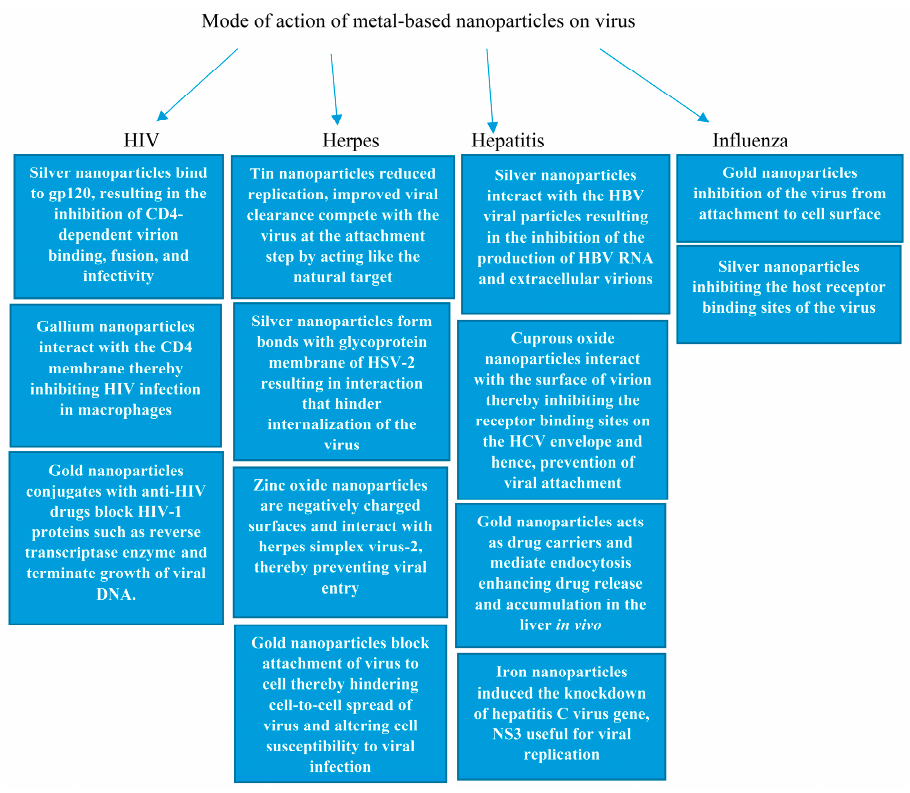
Figure 4. Mode of action of nanoparticles on microphages.